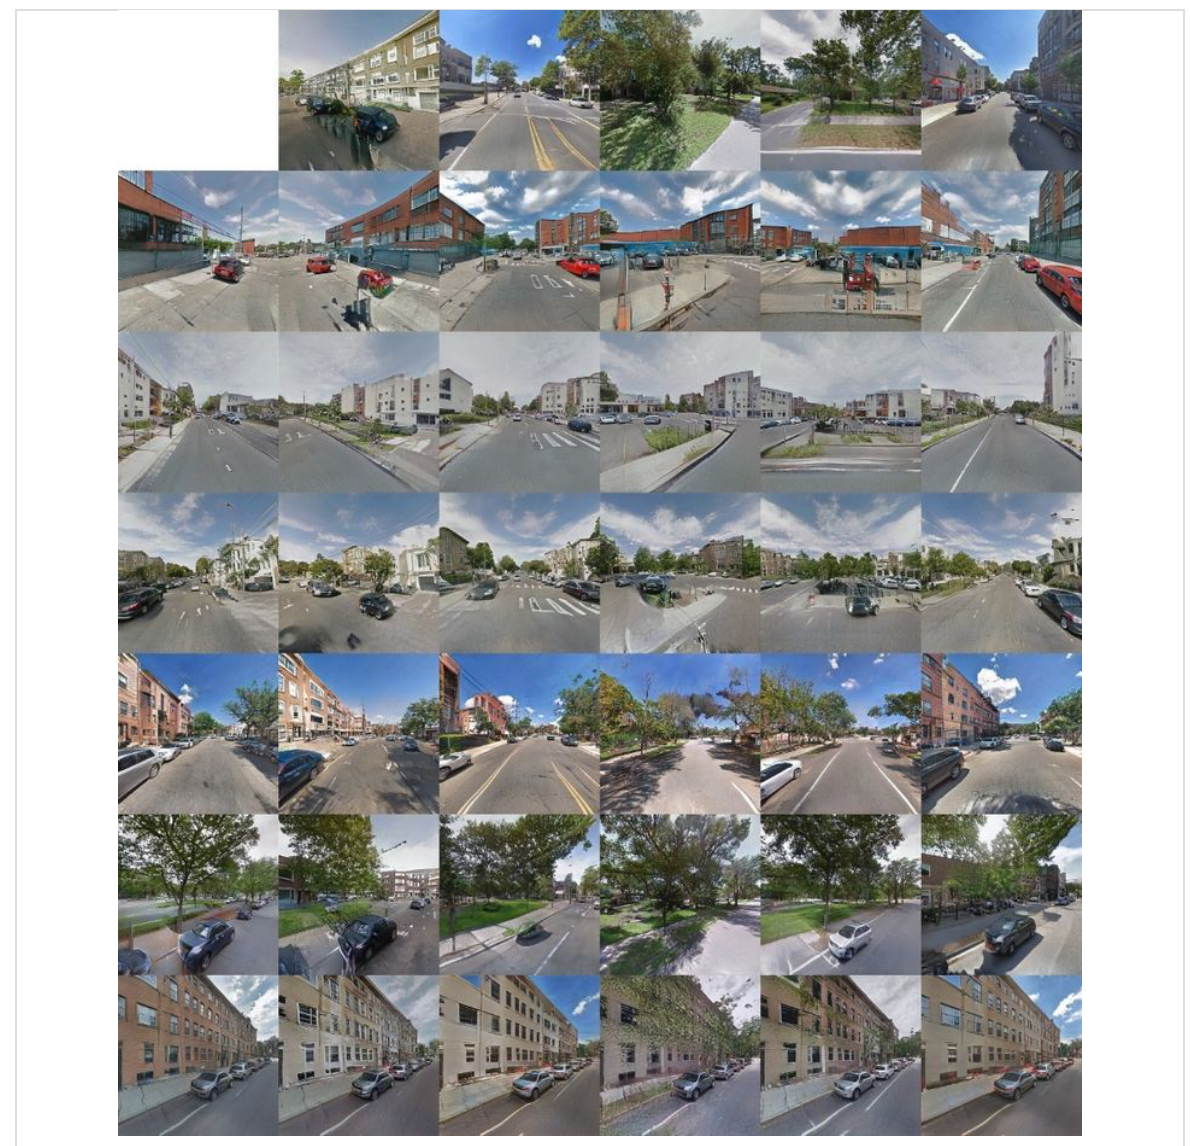
Figure 5. Synthetic images produced with Pix2Pix (5b and 5c) and StyleGAN (5d). The volume on the right-end side of the depthmap image (5a) “is interpreted by the Rotterdam model (5b) as a large brick housing block, as is typical in the Dutch city, while the Pickwick Park model (5c) renders this massing in a manner typical of the Northern Florida flora, suggesting the mass of a mossy Live Oak” (Steinfeld, 2019). In the images generated with StyleGAN, the “vertical columns define course features, such as camera direction and orientation, while horizontal rows define fine features, such as textures, colors, and lighting effects of each urban place” (Steinfeld,